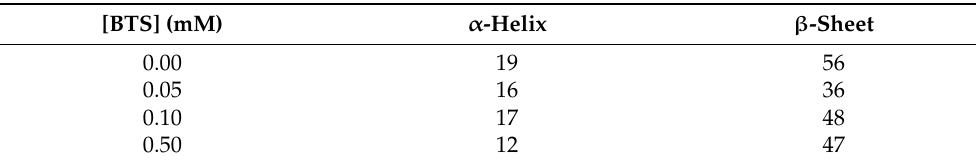
Table 1. Contents (in %) of the α -helices and β -sheets elements in lysozyme as a function of BTS concentration [21].